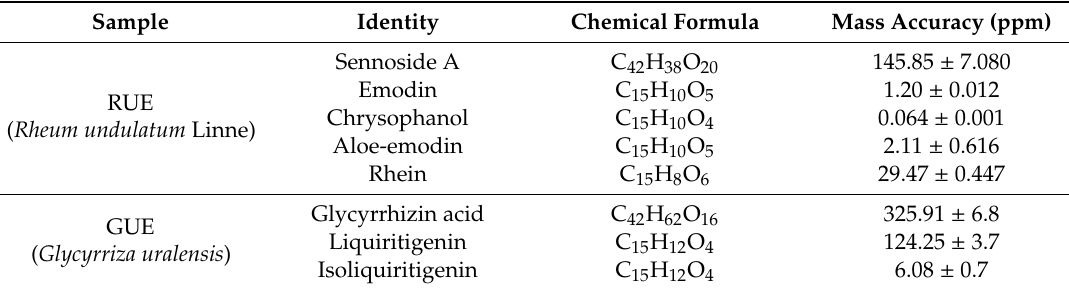
Table 1. Chemical formula and mass accuracy of potential ingredients.